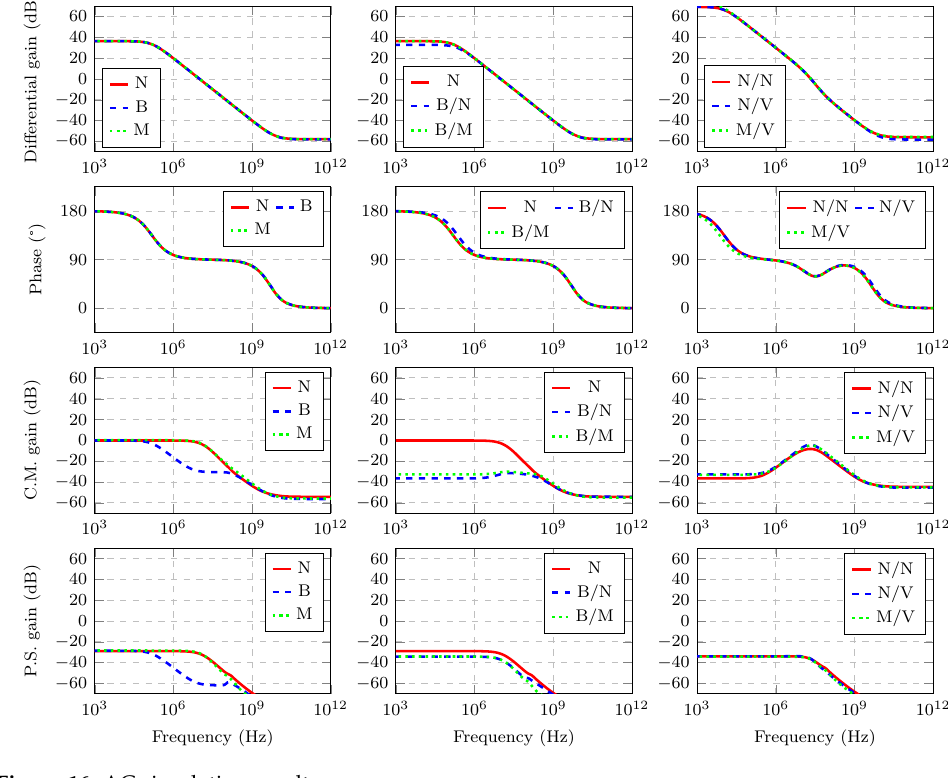
Figure 16. AC simulation results.